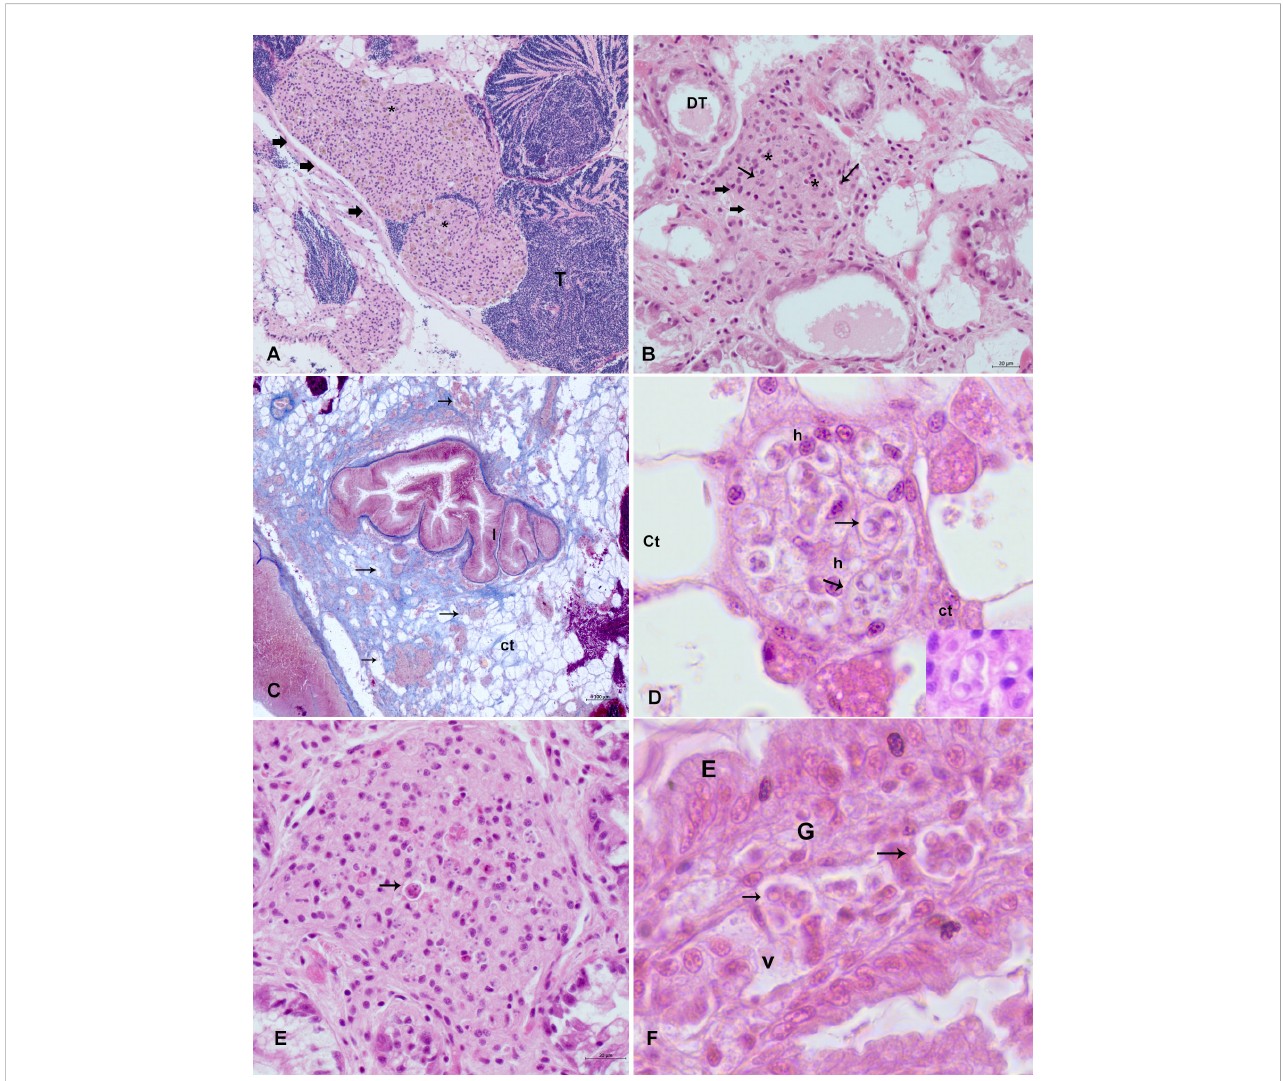
FIGURE 2 Histopathology of mussels affected by Perkinsosis in mussels ( M. galloprovincialis ) in Italy and Spain. (A, B) typical feature of the in fl ammatory lesion (big arrows) with haemocytes (*) related to Perkinsus (small arrows): haemocytes nodulation in gonadal follicle (A) and the interstitial space of digestive tubules (B) big arrows. (C) detail of the reactive connective tissue, underlined by Mallory Trichrome in light blue with in fl ammatory capsules (arrows); (D) detail of a capsule in the connective tissue space with haemocyte (h) phagocyting trophozoite of Perkinsus (arrow); (E) in fl ammatory capsule displaying apoptotic haemocytes (arrow) with visible trophozoite. (F) Perkinsus (arrows) in the gill (G) haemal vessel in samples from Spain; E, epithelium.